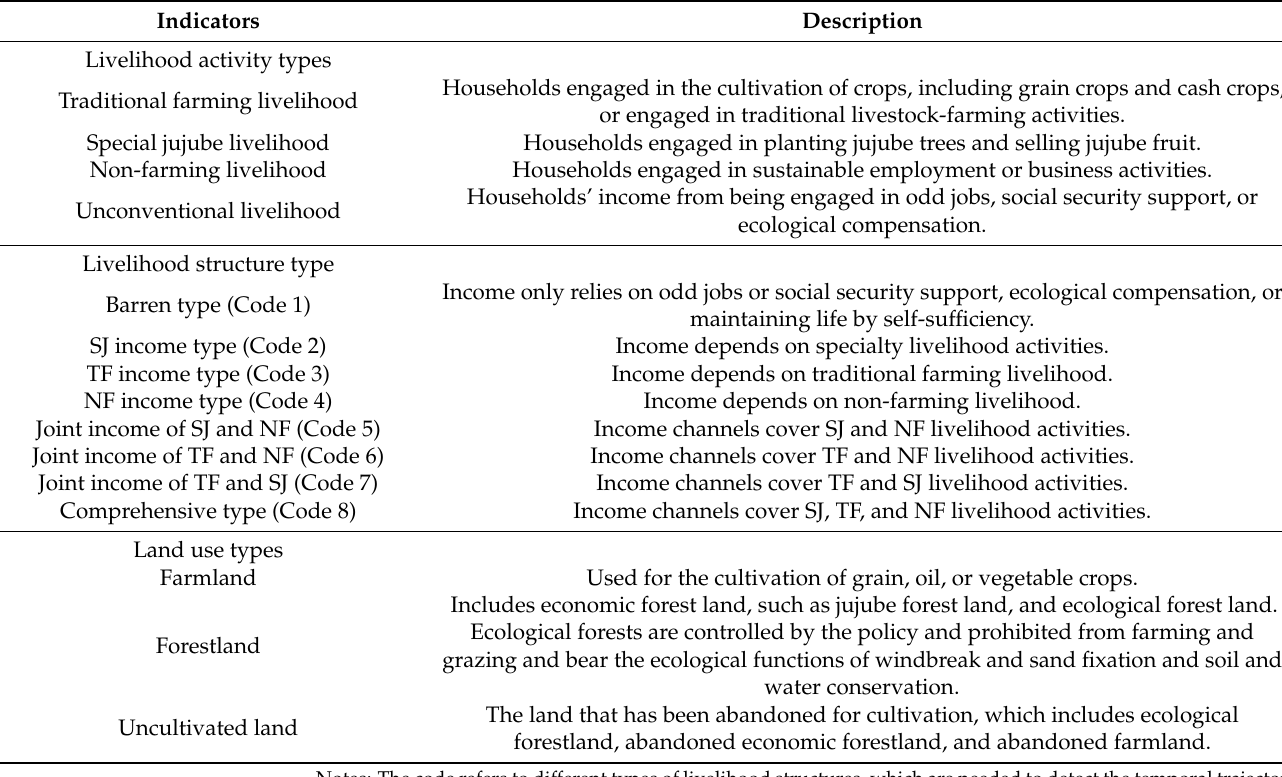
Table 1. Indicators of household livelihood and land use were used in the